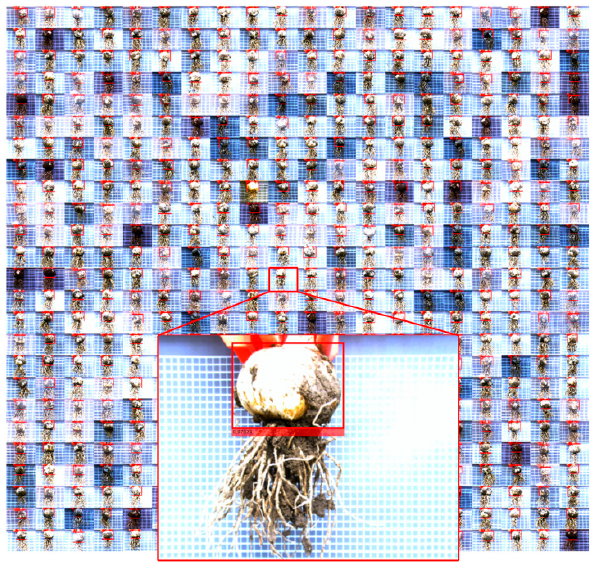
Figure 12. Results of the IRM-YOLOv2 detector on the test set.